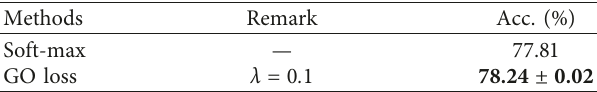
Table 8: Classification accuracy with DenseNet-BC on CIFAR-100 dataset.